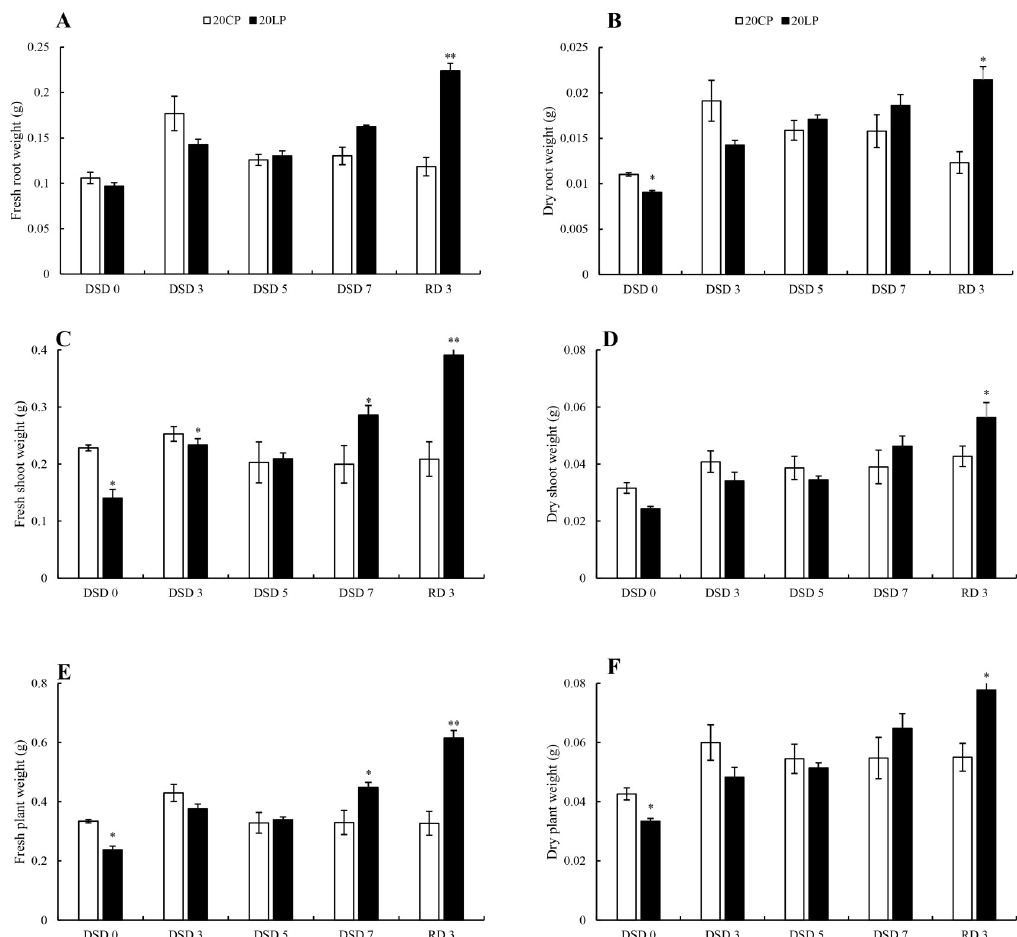
Fig 3. The fresh and dry weight of wheat plants. Note: CP: conventional phosphorus; LP: low phosphorus; Values are means ± standard deviation of three repetitions; � and �� indicate significantly different at p < 0.05 and p < 0.01, respectively. 20CP: Xindong20 under conventional phosphorus level; 20LP: Xindong20 under low phosphorus level.